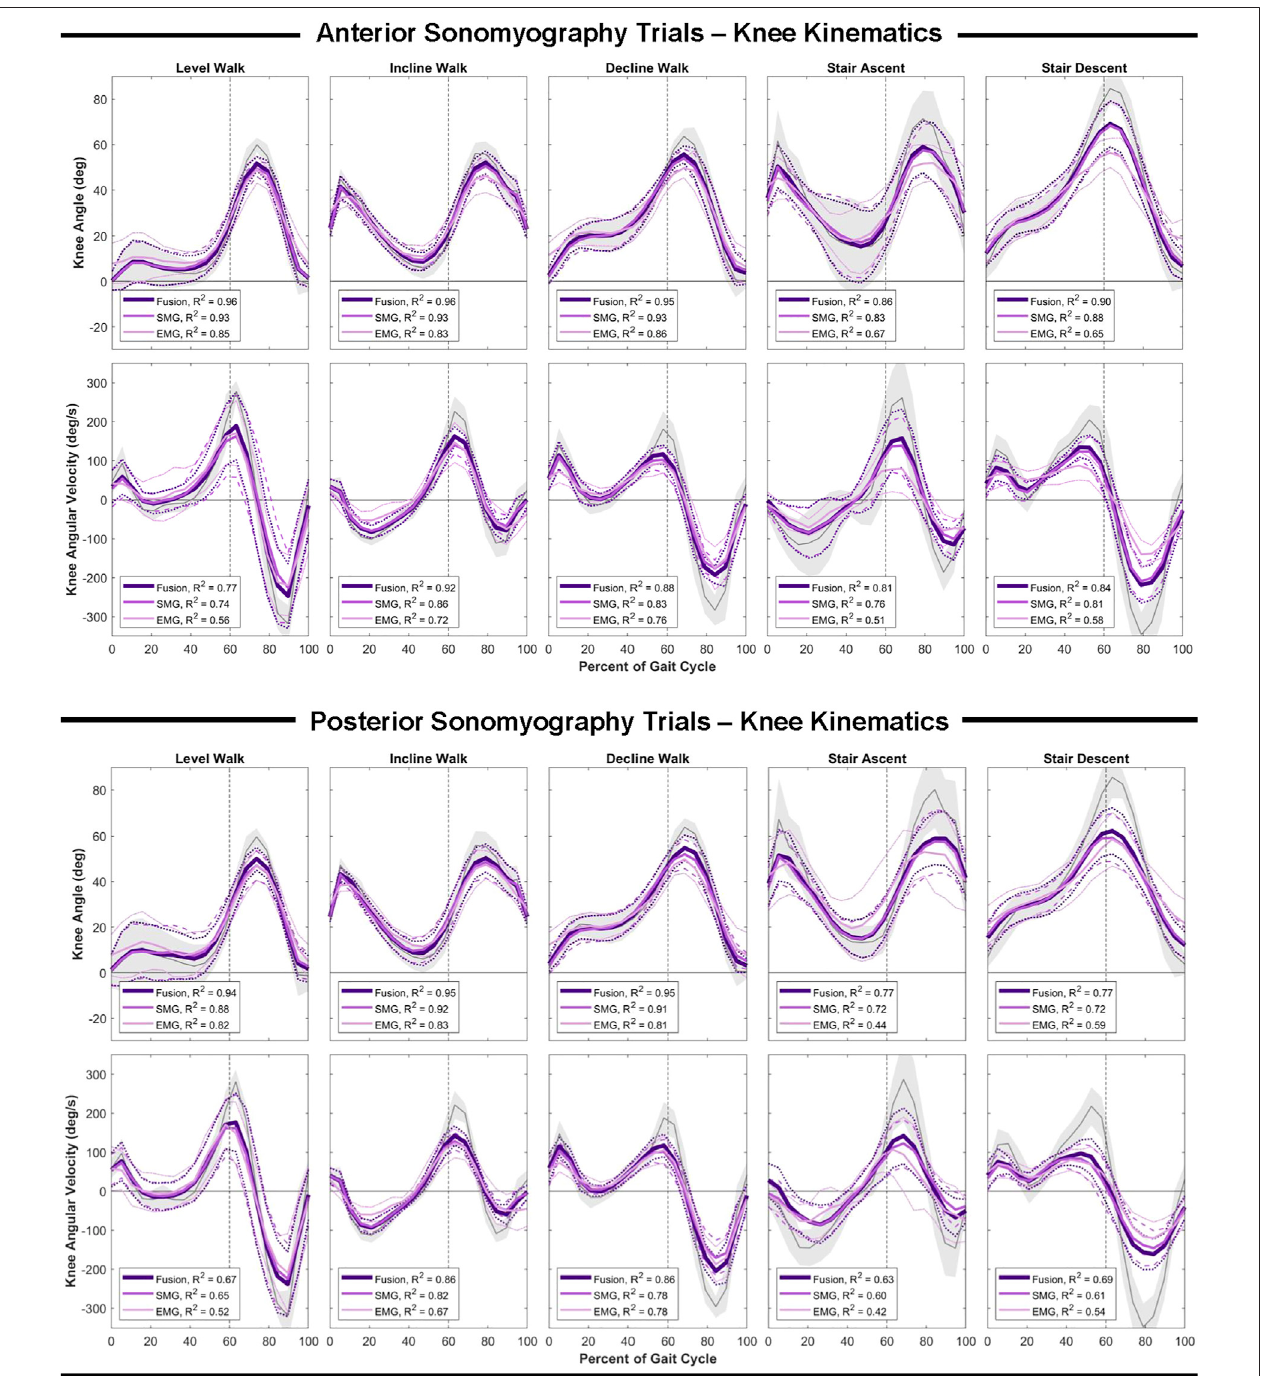
FIGURE 5 | Knee angle and angular velocity as a function of the gait cycle. Measured kinematics are displayed in gray with standard deviations in shaded regions. PredictedkinematicsfromGaussianprocessregressionmodelstrainedandtestedonfeaturesfromelectromyography(EMG),sonomyography(SMG)andsensorfusion (Fusion) are displayed with respective standard deviations. Adjusted R 2 given as a goodness-of- fi t metric for each sensing modality compared to the measured kinematics.